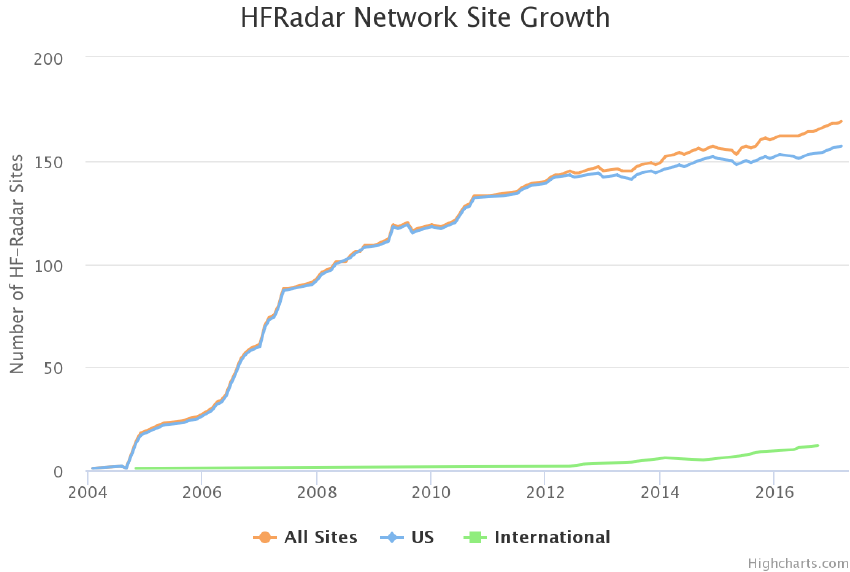
Figure 8. Growth of HF radar sites. Source: Coastal Observing Research and Development Center (CORDC), available at http://cordc.ucsd. edu/.